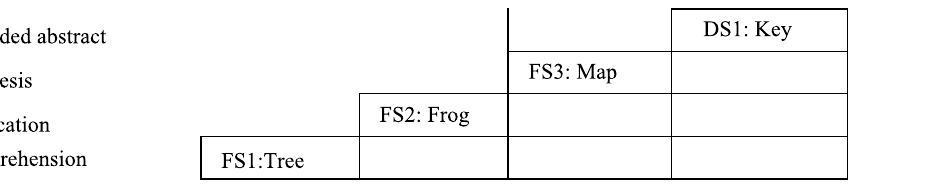
Figure 1. Taxonomy for benchmarking levels of critical